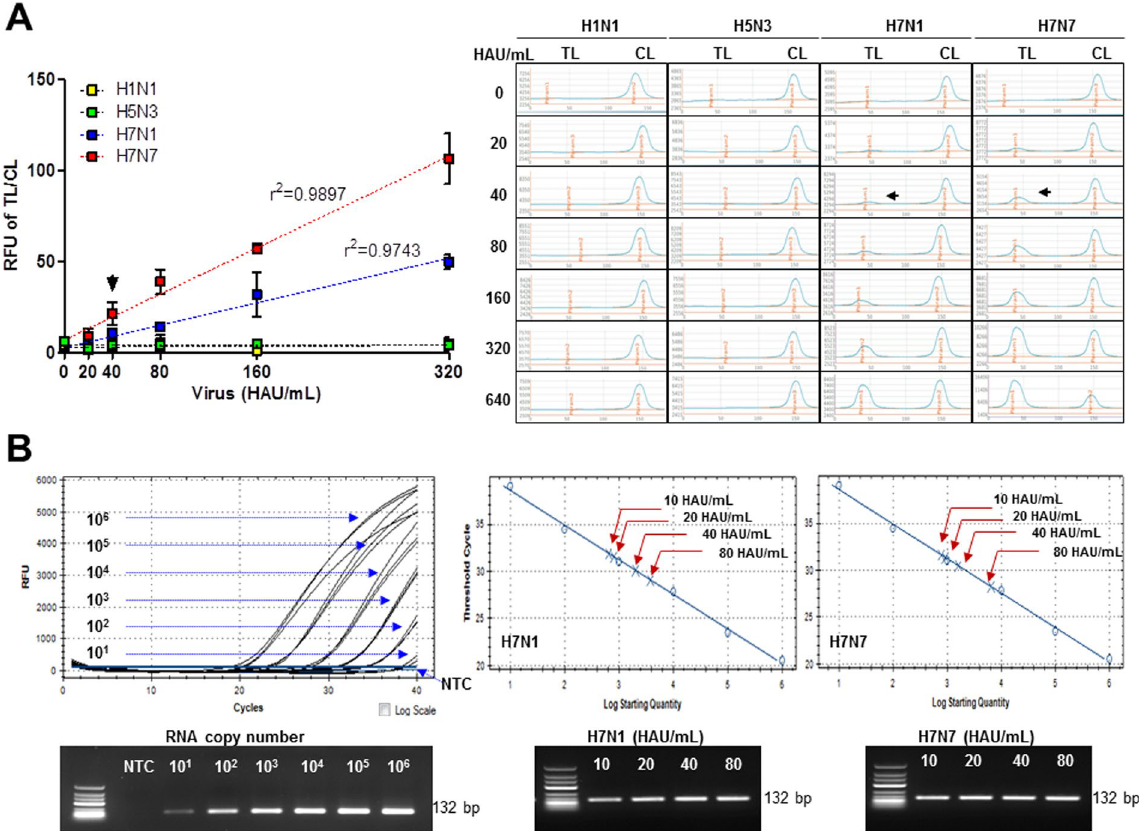
Figure 6. Assessment of FICT performance by rRT-PCR. Serially diluted virus (10–620 HAU/mL) was measured by FICT assay. The quantitative range of FICT assay was determined by linear regression using the GraphPad Prism 5.0 software, as shown by the dotted line ( A ). The black arrow indicates the virus titer of LOD of FICT assay. The data ( n = 3) are shown as mean ± SD. Raw fluorescence peaks from the test line (TL) and control line (CL) in FICT are shown in right panel. FICT assay was compared with rRT-PCR ( B ). The linear relationship between the threshold cycle (Ct) and RNA copy number was shown. After preparing two- fold dilutions from of 10 HAU/mL to 80 PFU/mL of two H7 subtype viruses, sample was subjected to RNA extraction and used for rRT-PCR. Bottom panel shows the PCR product of different RNA for standard and each diluted virus from 10–80 HAU/mL. The red arrow indicates the point that corresponds to the RNA copy numbers and virus titer. NTC, no template